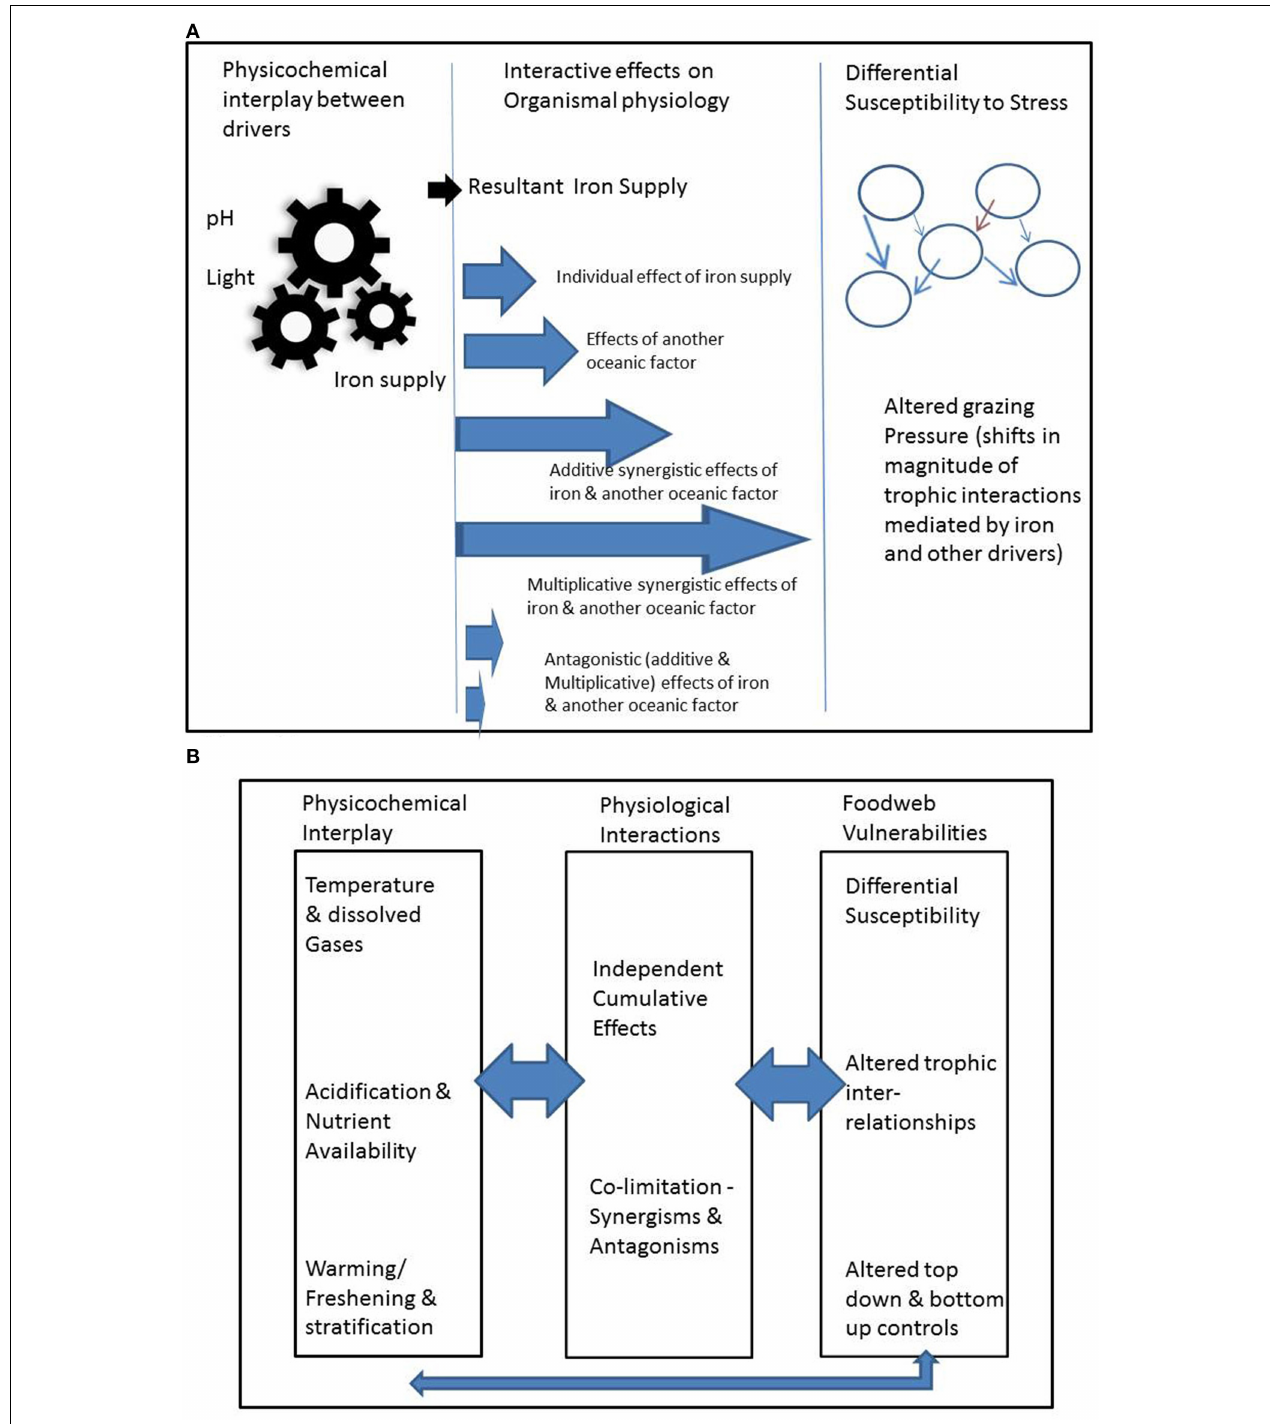
FIGURE 1 | Summary of the range of permutations associated with interlinked different modes of interactions, illustrated in (A) for iron supply for phytoplankton (note brown arrow in right hand panel denotes changes in foodweb interactions driven by floristic